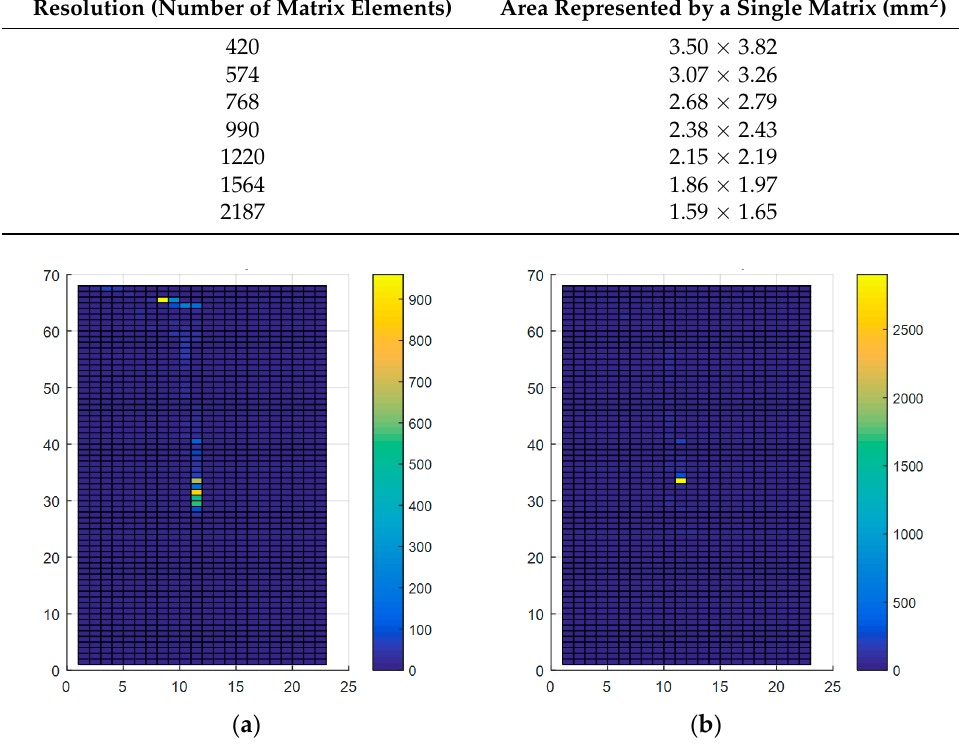
Figure 15. The matrix of pixels in two different situations with a resolution of 1564: ( a ) Adequate posture in Task 2; ( b ) Inadequate posture in Task 2.